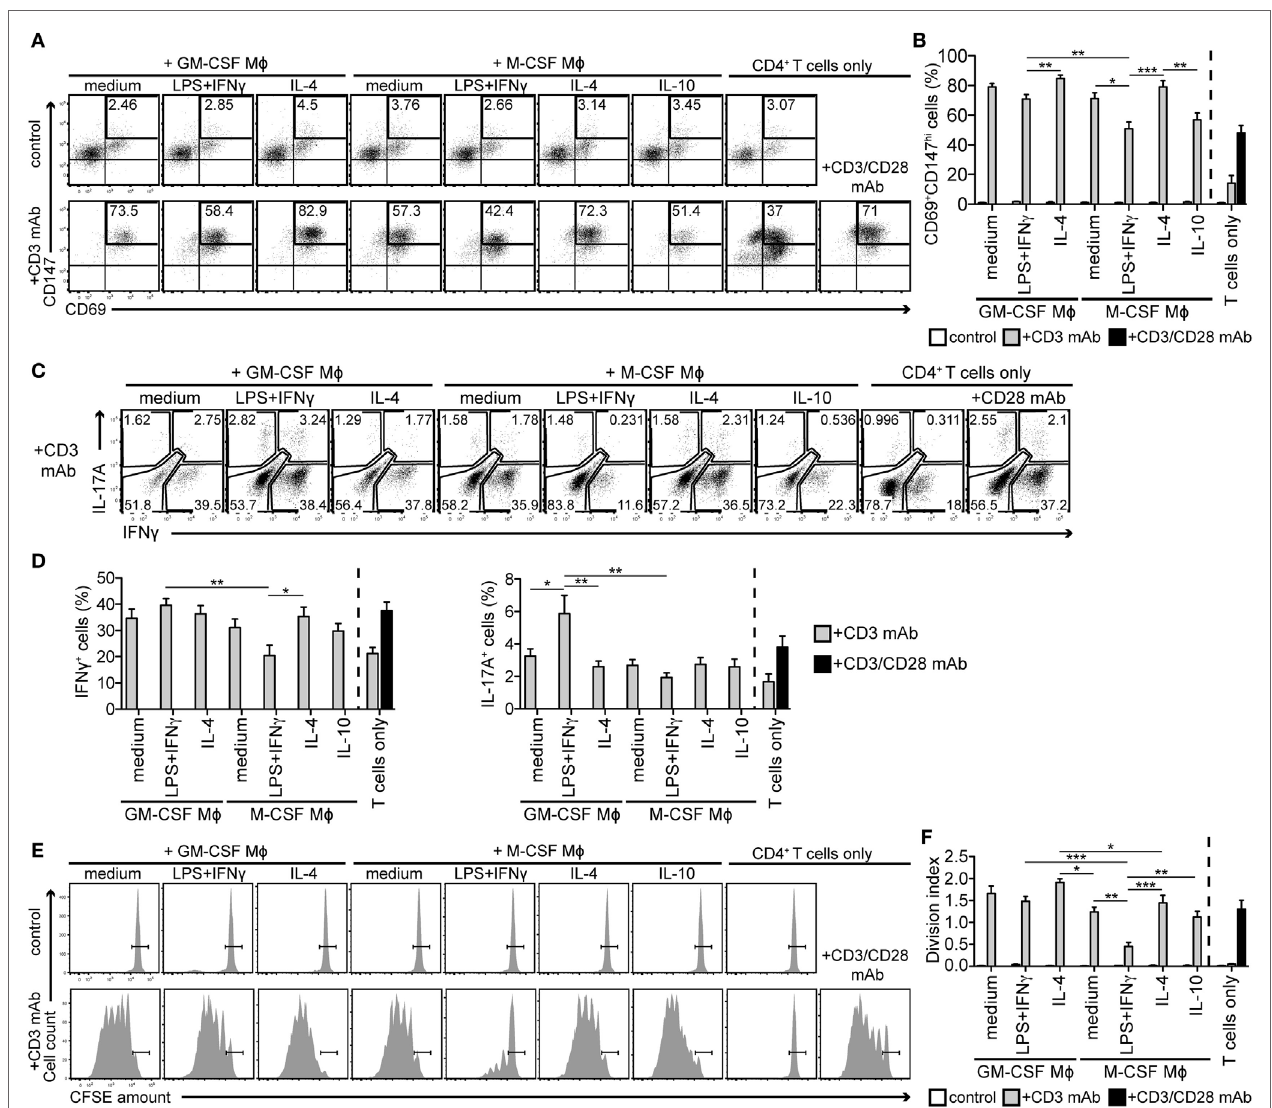
FigUre 2 | M-CSF-differentiated macrophages (M ϕ s) activated with LPS + IFN γ suppress activation, cytokine production, and proliferation of autologous CD4 + T cells. M ϕ s described in Figure 1 were cocultured with CFSE-labeled autologous CD4 + T cells in the presence or absence of the stimulating CD3 monoclonal antibody (mAb) OKT3. As a control, T cells were cultured alone as indicated. (a,B) CD4 + T cells were stained for activation markers CD69 and CD147 after 2 days coculture with different M ϕ subtypes. The percentage of activated cells is given in the CD69 + CD147 hi gate. One representative experiment (a) and statistics (B) of eight independent experiments is shown. (c,D) M ϕ subtypes were cocultured with unlabeled autologous CD4 + T cells in the presence of the CD3 mAb. After 5 days of coculture, T cells were restimulated with phorbol 12-myristate 13-acetate and ionomycin for 6 h and stained for IFN γ and IL-17A. One representative experiment (c) and the mean percentages (representing the sum of the respective single and double-positive gates) ± SEM (D) of the IFN γ - and IL-17A-expressing T cells of seven independent experiments are shown. (e) Proliferation of CFSE-labeled T cells cocultured with autologous M ϕ s ± CD3 mAb was determined by CFSE dilution on day 7 using flow cytometry. One representative experiment, where CFSE hi non-dividing cells are gated, of nine independent experiments is shown. (F) T cell division index was calculated according to the CFSE peaks. Data represent means ± SEM of nine independent experiments. Expression of activation markers (B) , cytokines (D) , and proliferation (F) of the CD3-stimulated T cells in M ϕ cocultures were statistically evaluated by one-way ANOVA with Tukey’s posttest; * p < 0.05, ** p < 0.01, *** p <